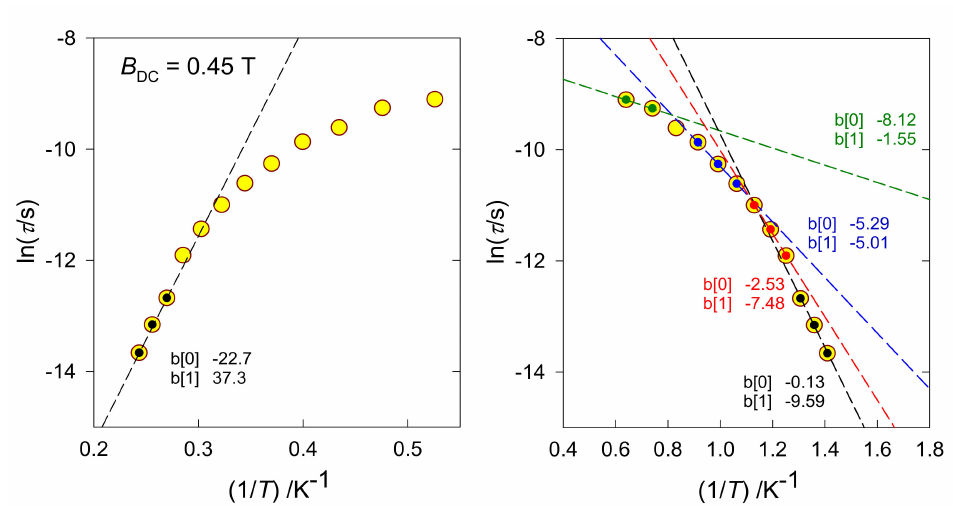
Figure 5. Contributions to the relaxation time. ( Left ): Orbach process (high-temperature, black, U eff / k B = 37 K). ( Right ): direct process (low-temperature, green, m ~ 1, Raman process; intermediate temperature, blue, n > 5; red n < 9). Data adapted from [20] for a mononuclear Fe III complex. Straight-line formula: y = b [0] + b [1] x .